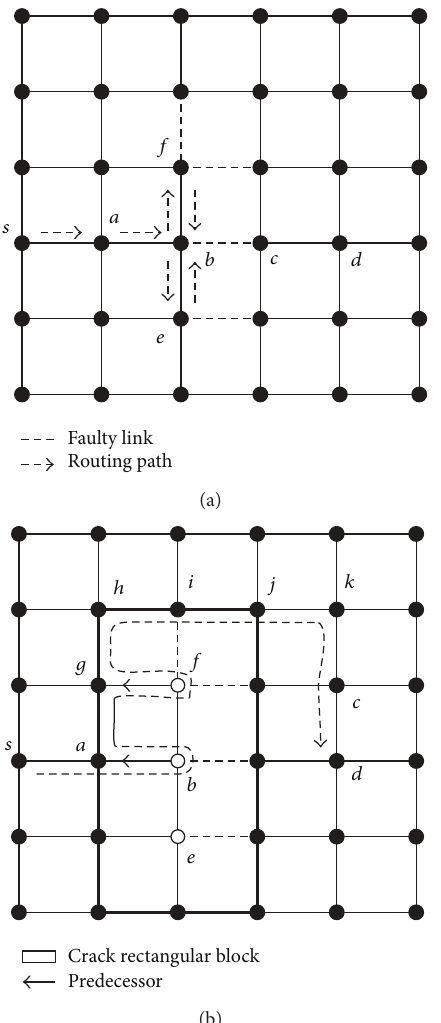
Figure 2: (a) Livelock situation in 𝑀(𝑑 1 , 𝑑 2 ) : node 𝑠 tries to send a message 𝑚 tonode 𝑑 ,but 𝑚 isinalivelockinducedbynodes 𝑏, 𝑒 ,and 𝑓 caused by the faulty links. (b) Cracky rectangular block solves the livelock problem, and the message 𝑚 will be sent to its destination along the node sequences 𝑠,𝑎, 𝑏, 𝑎, 𝑔,𝑓,𝑔, ℎ,𝑖, 𝑗, 𝑘, 𝑐 , and 𝑑